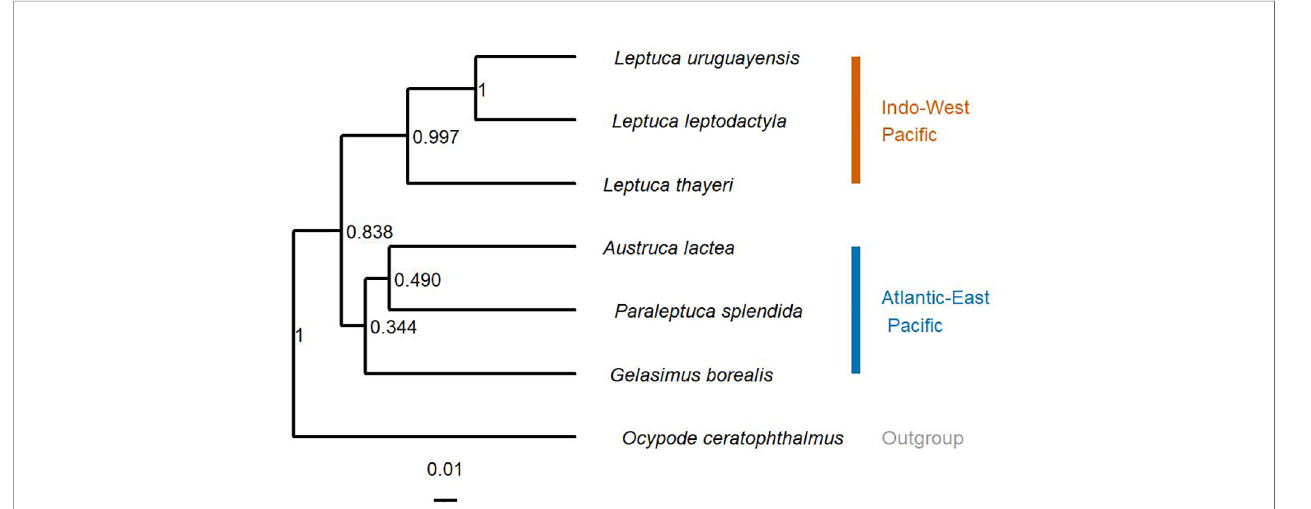
FIGURE 3 | Phylogenetic relationships among species of fi ddler crabs from the Atlantic-East Paci fi c and Indo-West Paci fi c. Ocypode ceratophthalmus is an outgroup. Node numbers are the posterior probability from the Bayesian